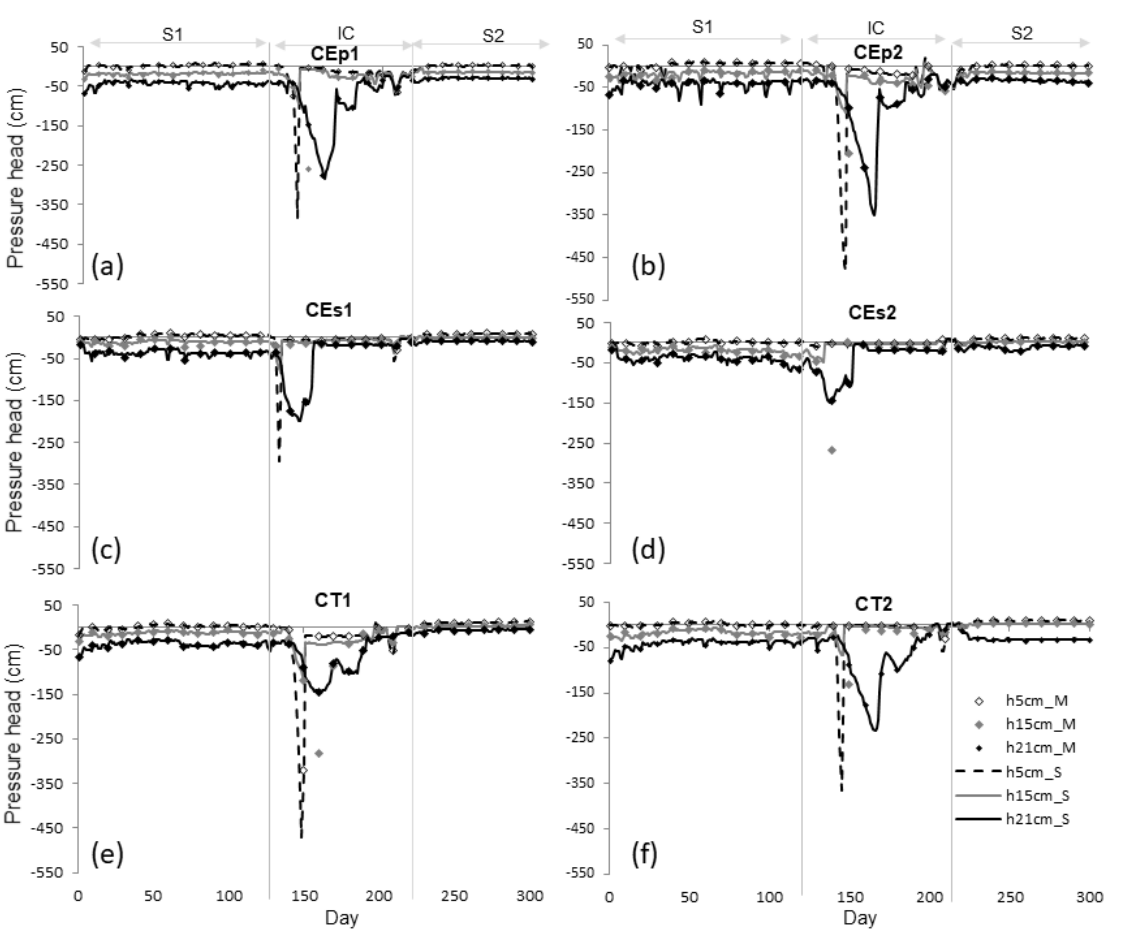
Figure 2. Dynamics of the pressure head (h) measured with tensiometers (M) and simulated with Hydrus − 1D (S) at 5, 15 and 21 cm soil depths in soil columns for the three treatments during the experiment. S1 is the first cropping season, IC is the intercropping season, S2 is the second cropping season, CEp1 ( a ) and CEp2 ( b ) are the columns cultivated permanently with E. stagnina , CEs1 ( c ) and CEs2 ( d ) are the columns cultivated with seasonal E. stagnina , and CT1 ( e ) and CT2 ( f ) are the columns with bare soil.